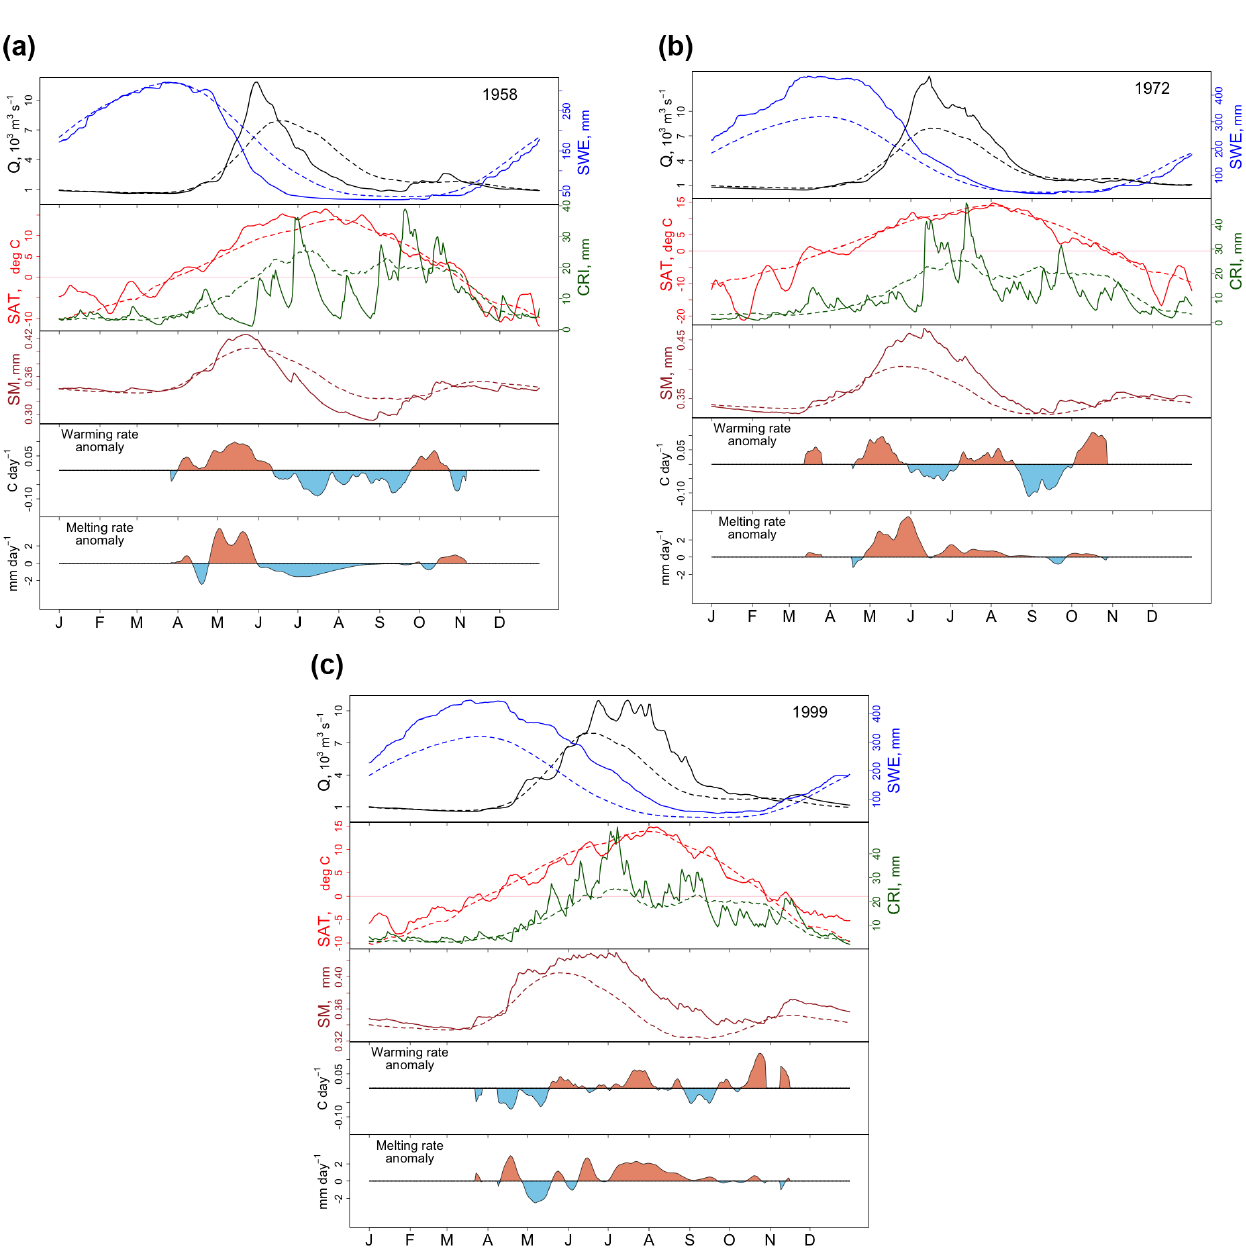
Figure 9. Annual cycles of key variables from the VIC simulation, constructed from daily output. Results for three high-APF years are shown: (a) 1958; (b) 1972; and (c) 1999. In each panel, sub-panels show, from top to bottom: streamflow (black, left-hand axis); SWE (blue, right-hand axis); surface air temperature (red, left-hand axis); current rainfall index, CRI (green, right-hand axis); soil moisture (brown); warming rate anomaly; and melting rate anomaly. In the upper three sub-panels, solid curves show time series for the year indicated at top right, while dashed curves show the multi-year (1955–2004) mean climatology. The calculations underlying the lower two sub-panels are described in Sect.